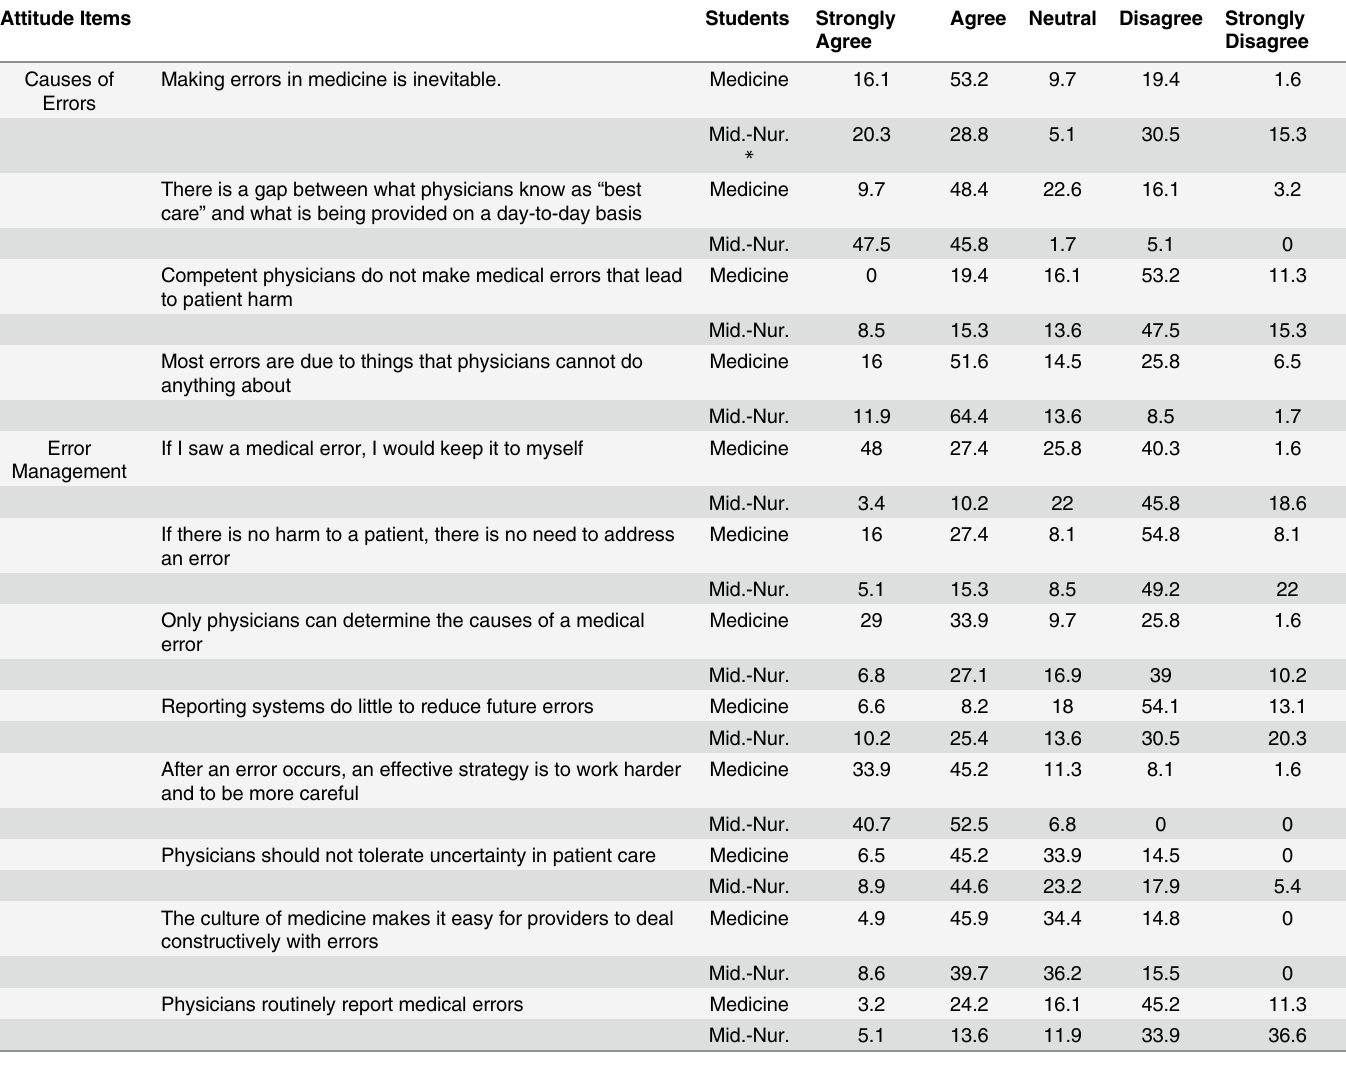
Agree Neutral Disagree Strongly Agree Disagree